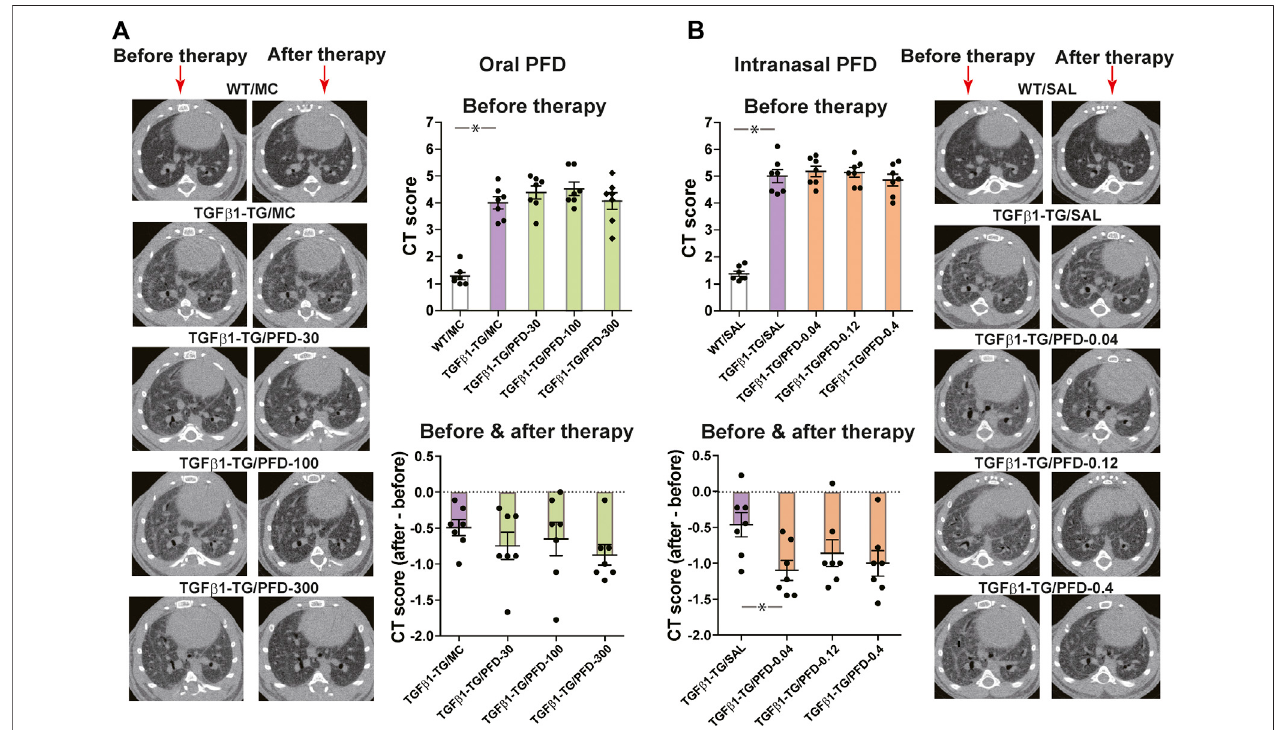
FIGURE1| Computedtomography(CT)scoreof fi brosissigni fi cantlyimprovedaftertreatmentwithalowdoseofintranasalpirfenidone(PFD)comparedtocontrol. Human transforminggrowth factor (TGF) β 1transgenic (TG) mice wereallocatedin groups treated withPFD by oral( A ; n (cid:2) 7)or intranasal ( B ; n (cid:2) 7) administration and in groupstreatedwiththevehiclesaline(SAL; n (cid:2) 7)orwiththevehiclemethylcellulose(MC; n (cid:2) 7)twiceadayfor21daysandonceadayonday22beforeeuthanasia.Wild type (WT; n (cid:2) 7) mice treated with saline or MC were used as negative controls. CT was performed as described under materials and methods. CT score of each mouse is the mean score of nine readers blinded for the treatment and mouse groups. Data are expressed as the mean ± S.E.M. Statistical analysis by Student ’ s t -test and ANOVA with Dunnett ’ s post hoc test. * p <